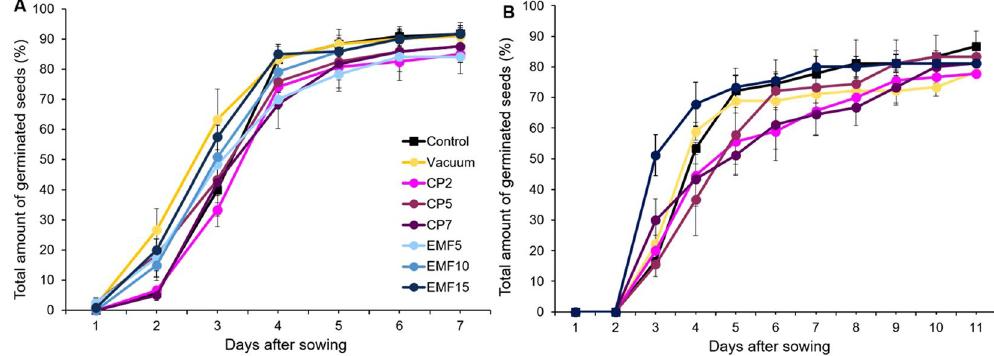
Figure 1. Germination dynamics of sunflower seeds in vitro ( A ) and in substrate ( B ). The points represent mean values of three replicates ± standard error of mean. Seed treatments for all experimental conditions were replicated three times (n = 30 for one